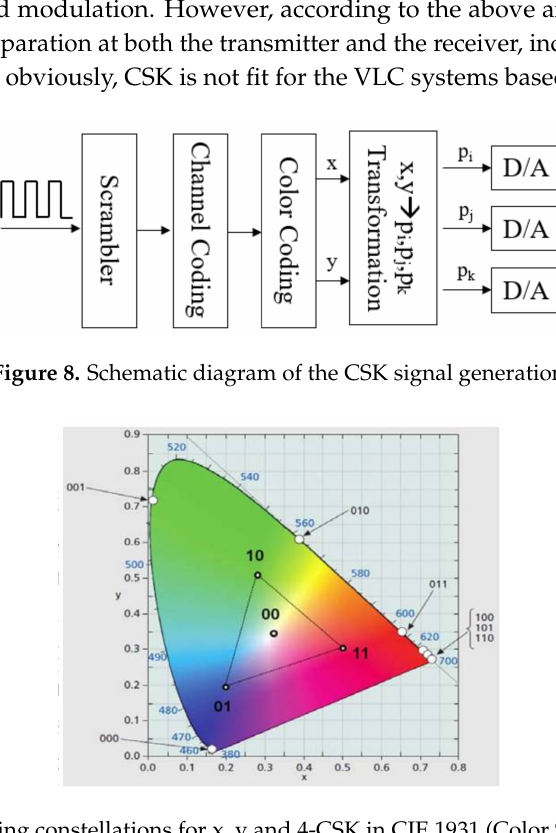
Figure 9. Color mapping constellations for x, y and 4-CSK in CIE 1931 (Color Space proposed by the International Illumination Organization in